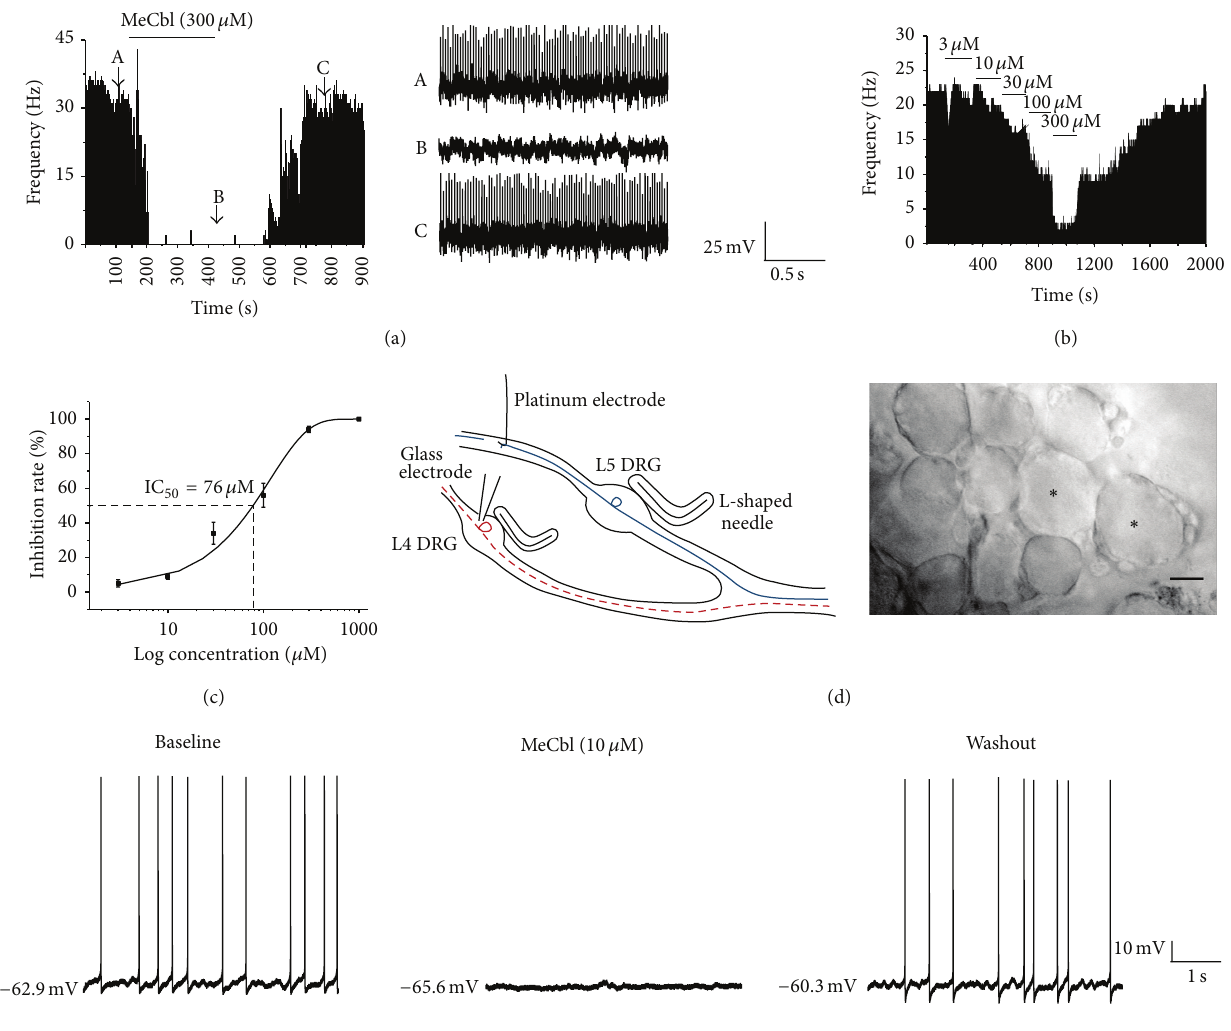
Figure 3: MeCbl inhibited spontaneous activity (SA) of A-type neurons of the compressed DRG in a dose-dependent way. (a) Time histogram shows that the application of MeCbl (300 𝜇 M) decreases the basal firing rate of an A-type dorsal root fiber in vivo . Three traces in right panel were showed firing patterns before (A), during (B) and wash (C) the application of MeCbl. (b) Time histogram shows the inhibitory effect of MeCbl in a dose-dependent manner. (c) The concentration-response curve shows the value for IC 50 (76 𝜇 M) of MeCbl. (d) Schematic graph of whole-cell recording of DRG neurons and photography of medium-sized DRG neurons. Scale = 20 𝜇 m. (e) MeCbl (10 𝜇 M) inhibited the SA of one medium-sized DRG neuron of CCD